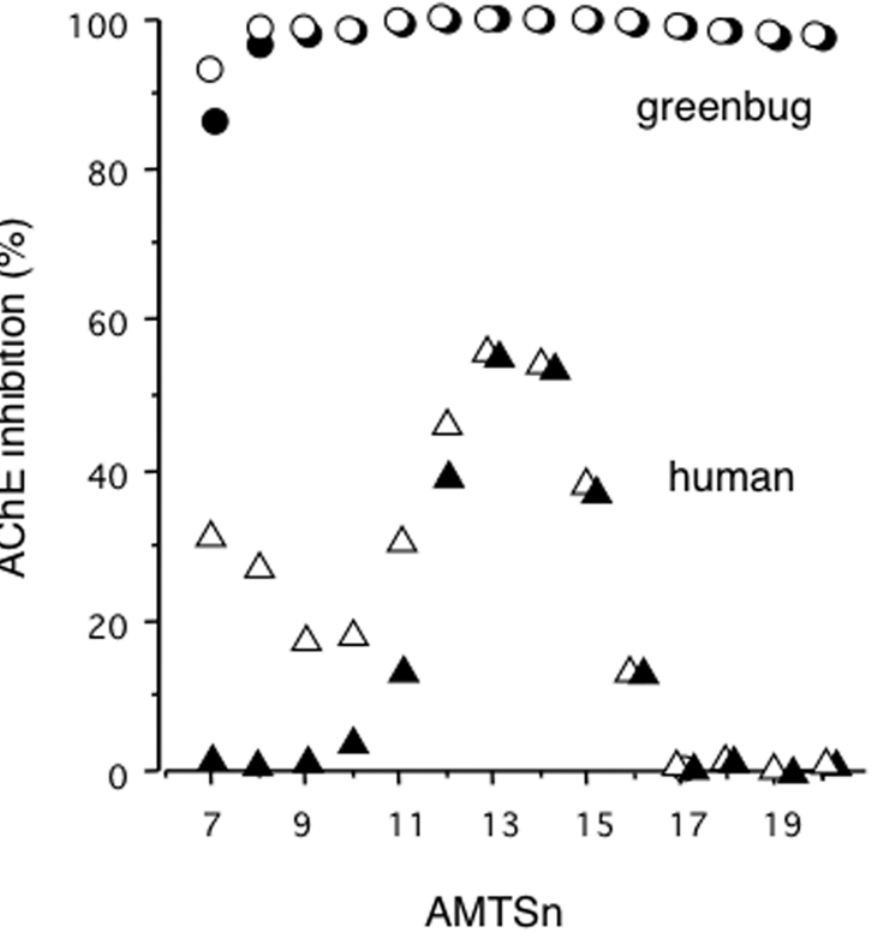
Figure 5. Inhibition of the greenbug and human AChEs by AMTS7–AMTS20. Extracts of greenbugs and human RBCs in 0.1 M sodium phosphate buffer (see Methods) were exposed to AMTS7 – AMTS20 at 6.0 m M for one hour at room temperature. Radiometric assays were used to determine AChE activity in aliquots of treated samples either immediately (empty symbols) or after overnight dialysis with 2 changes of buffer in 100- fold excess (filled symbols). The difference between the paired measurements (i.e., the recovery after dialysis) indicates reversible